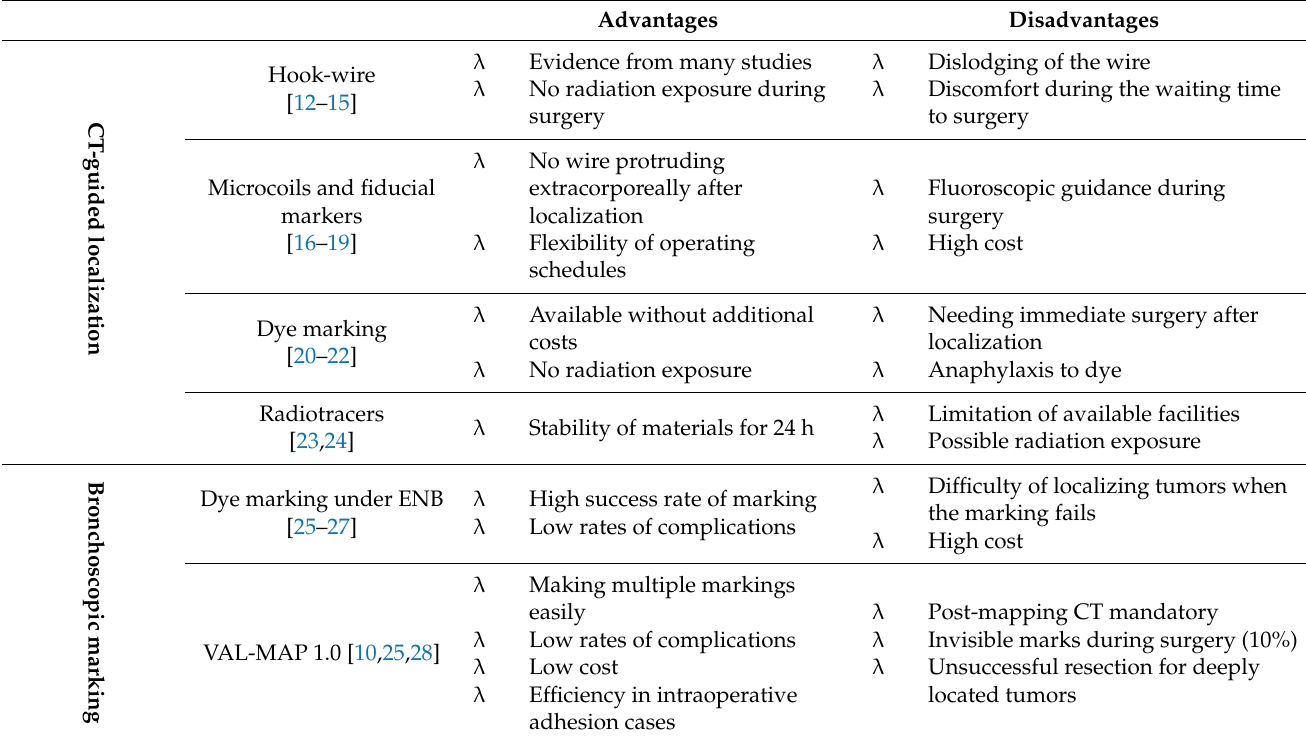
Table 1. Advantages and disadvantages of CT-guided localization and bronchoscopic